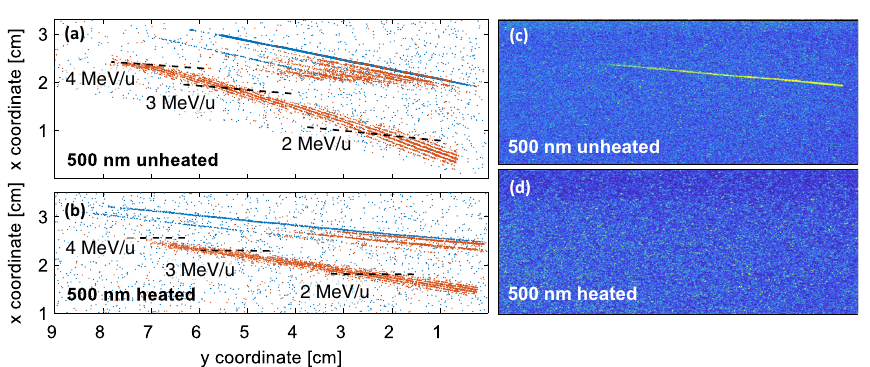
500 nm unheated